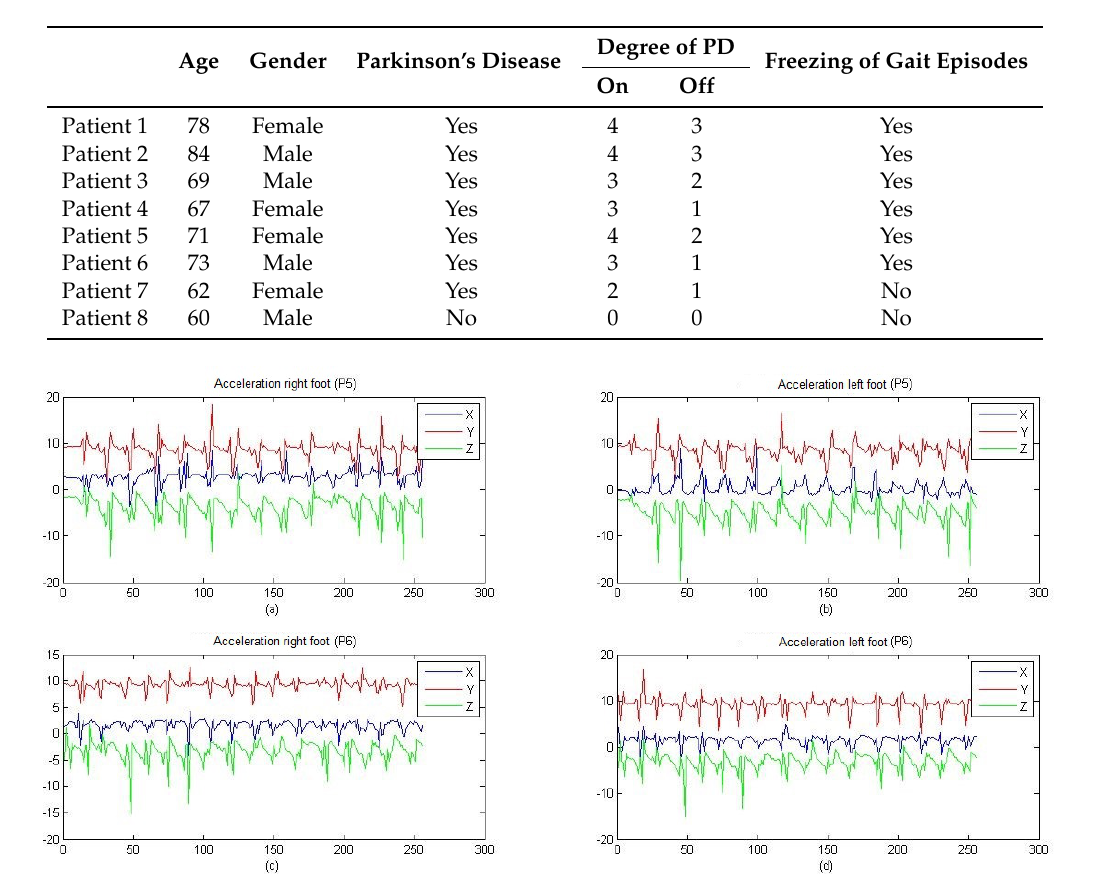
Table 2. Characteristics of the patients evaluated.